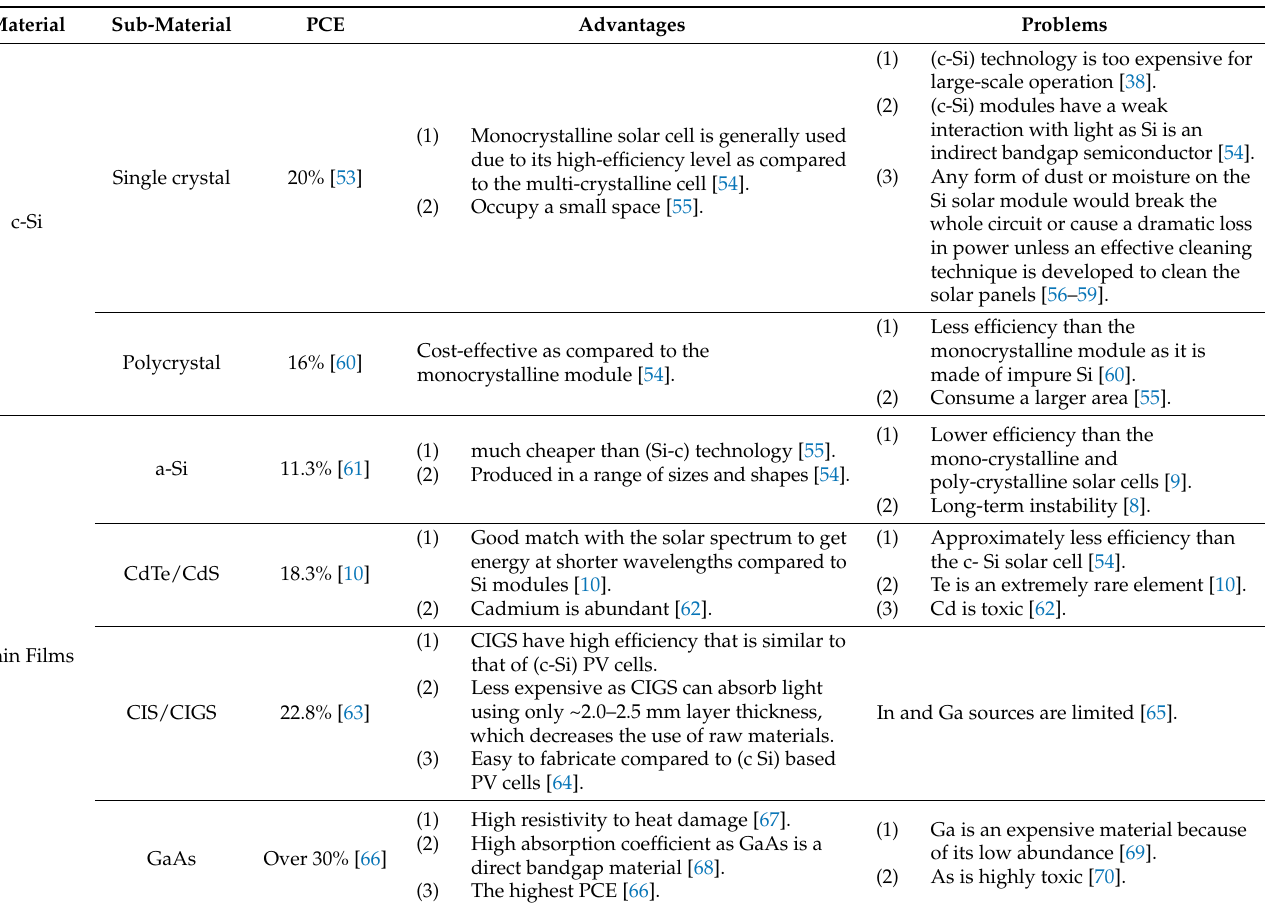
Table 1. A comparison between the typical types of materials used in PV solar